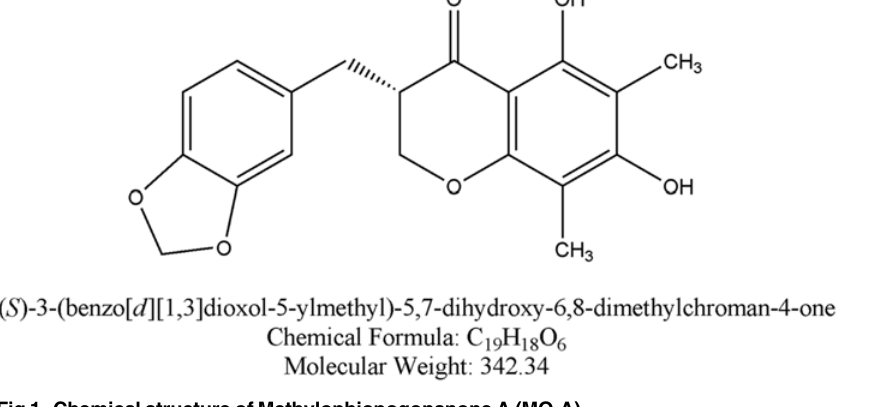
Fig 1. Chemical structure of Methylophiopogonanone A